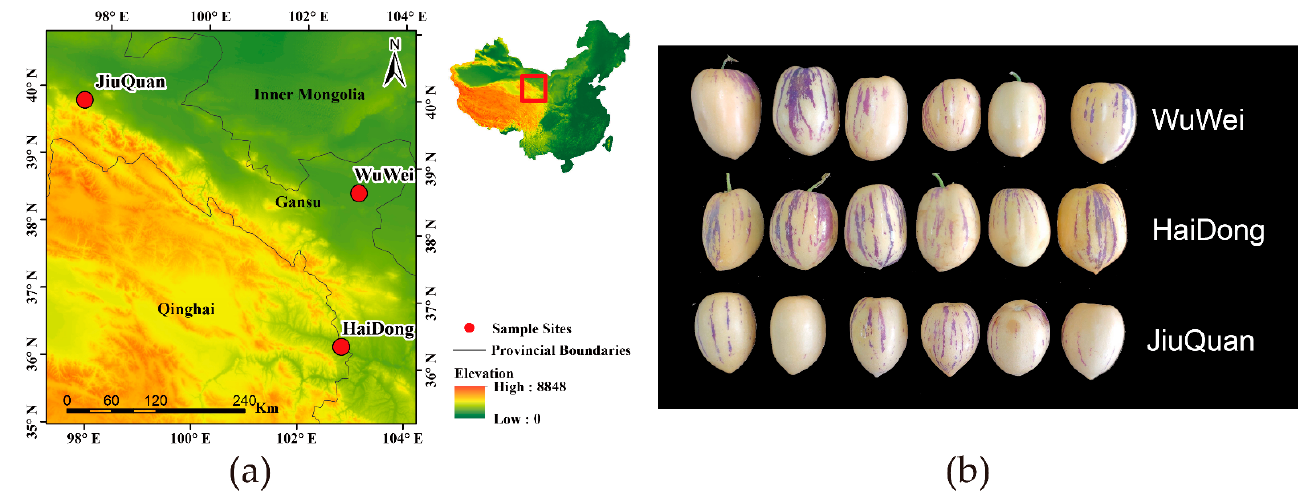
Figure 1. ( a ) Map of the sampling sites; ( b ) fruit phenotypes of pepino.